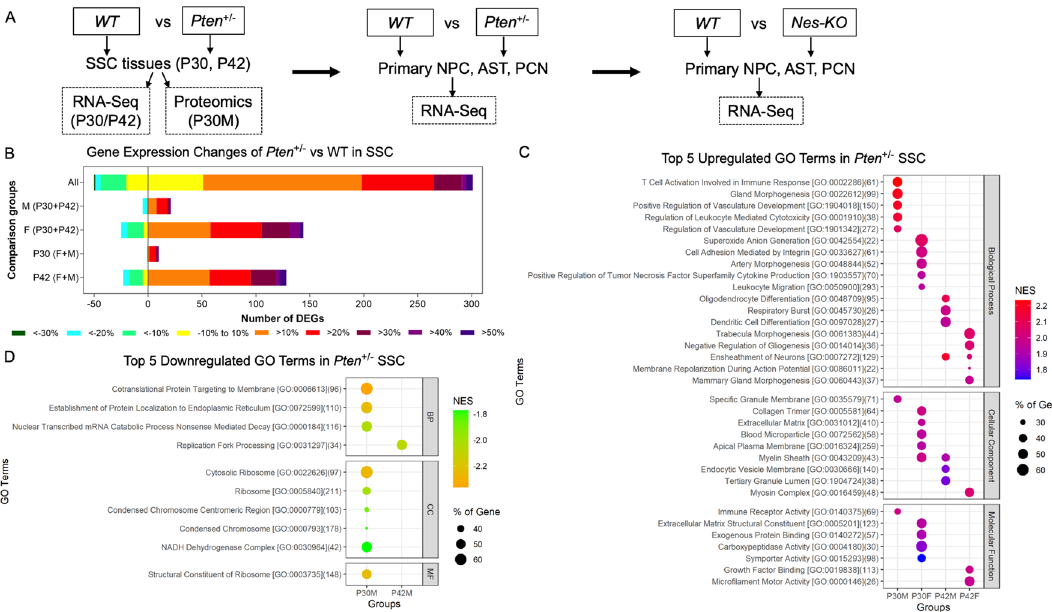
Figure 1. Transcriptomic analysis reveals increased immune response and oligodendrocyte development in somatosensory cortex. ( A ) Workflow of current study summarizing the genotypes, stages, cell types, and molecular techniques used. ( B ) Number of protein coding genes that were differentially expressed (false discovery rate < 0.05) in the somatosensory cortex of male (M) and female (F) Pten +/− mice at P30 ( male: n=3 for wild-type, and n=2 for Pten +/− ; female: n=3 for wild-type and Pten +/− ) and P42 (n = 3 for each group). Differentially expressed genes (DEGs) are stratified by their percentage fold change ( Pten +/− vs. wild-type). Age and sex-independent analysis after pooling P30M, P30F, P42M and P42F groups; M (P30 + P42), male-specific analysis after pooling P30M and P42M groups; F (P30 + P42), female-specific analysis; P30 (F + M), P30-specific analysis after pooling P30F and P30M groups; P42 (F + M), P42-specific analysis after pooling P42F and P42M groups. ( C ) Top five upregulated Gene Ontology (GO) terms in each group. ( D ) Top five downregulated GO terms in each